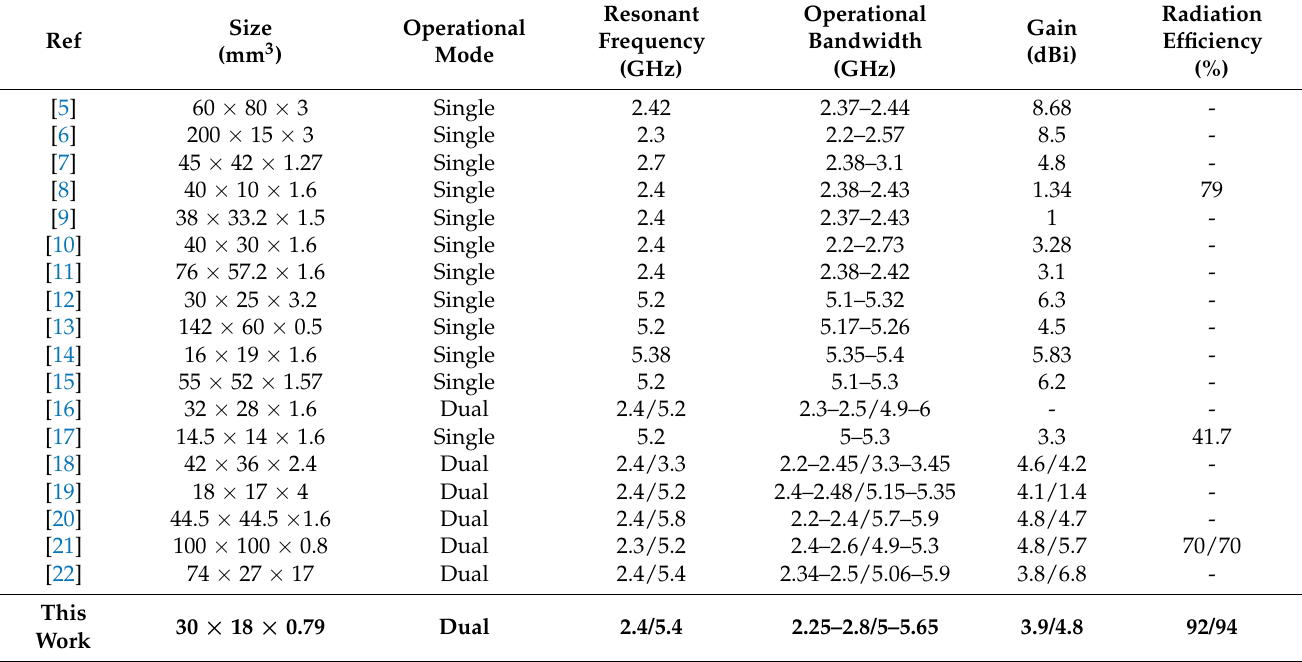
Table 1. Comparison of proposed dual-band antenna with the previously presented antennas in the literature operating at same